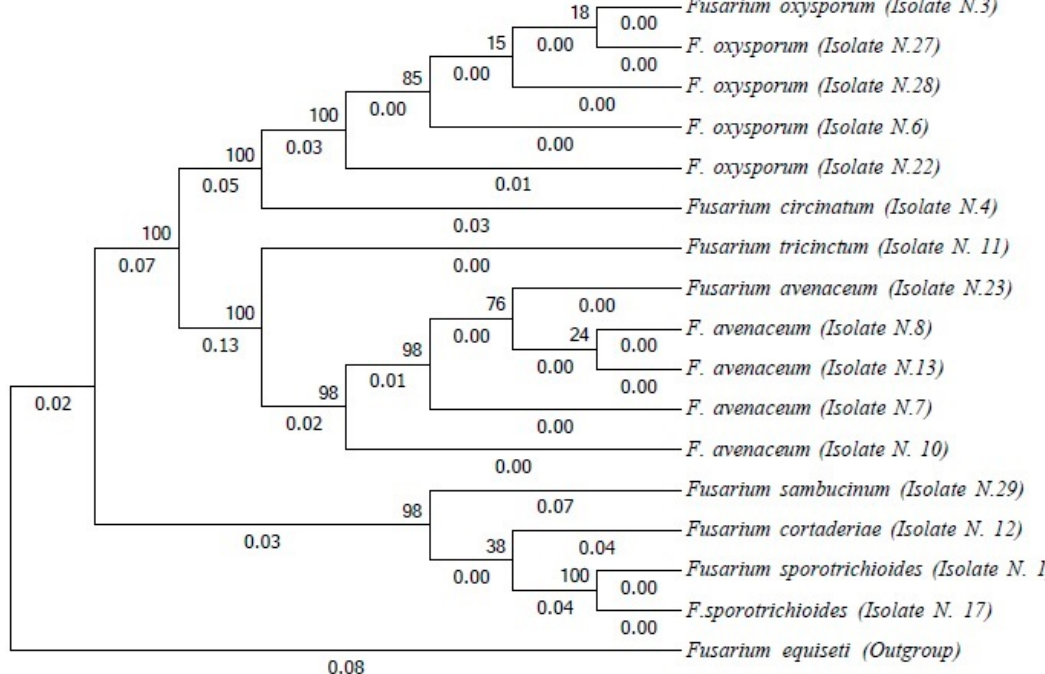
Figure 6. Phylogenetic tree inferred using the neighbor-joining method. The percentage of replicate trees in which the associated taxa clustered together in the bootstrap test (1000 replicates) is shown next to the branches. The evolutionary distances are in the units of the number of base substitutions per site.